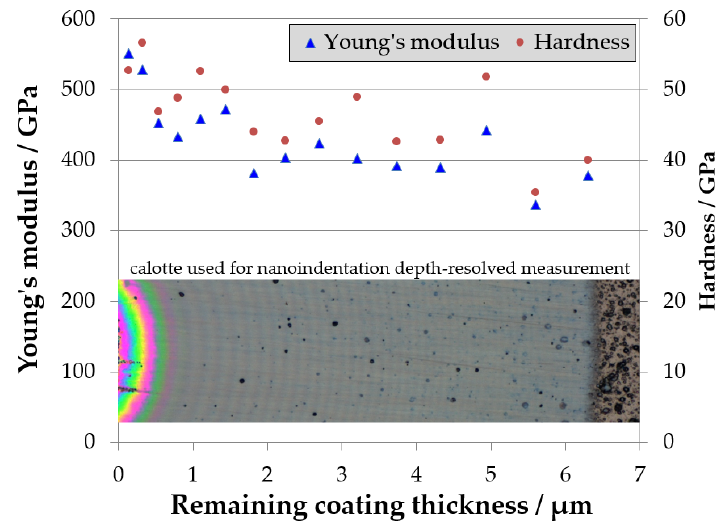
Figure 5. Young’s modulus and hardness values measured by nanoindentation in coating D. The values were obtained in different remaining coating thicknesses using a wedge-shaped area which was created by grinding a calotte into the layer. A microscope image of a calotte area is included.